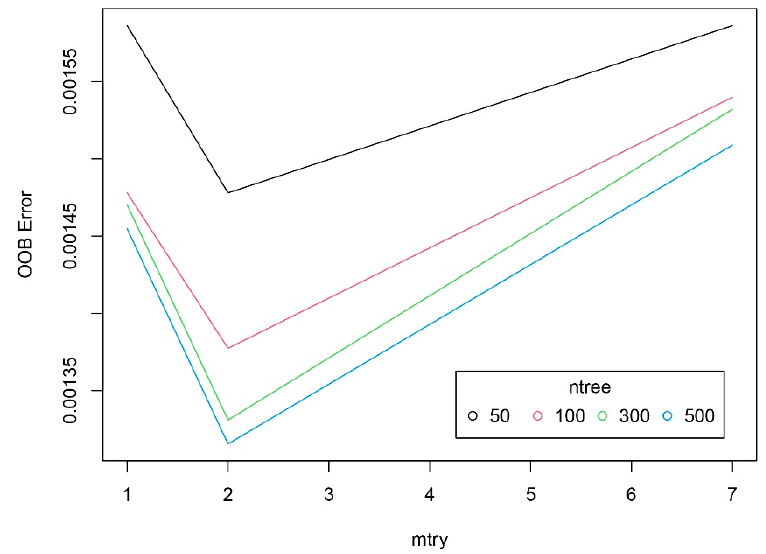
Figure 4. Out-of-bag (OOB) error of the random forests classifier with different parameter values of mtry and ntree .